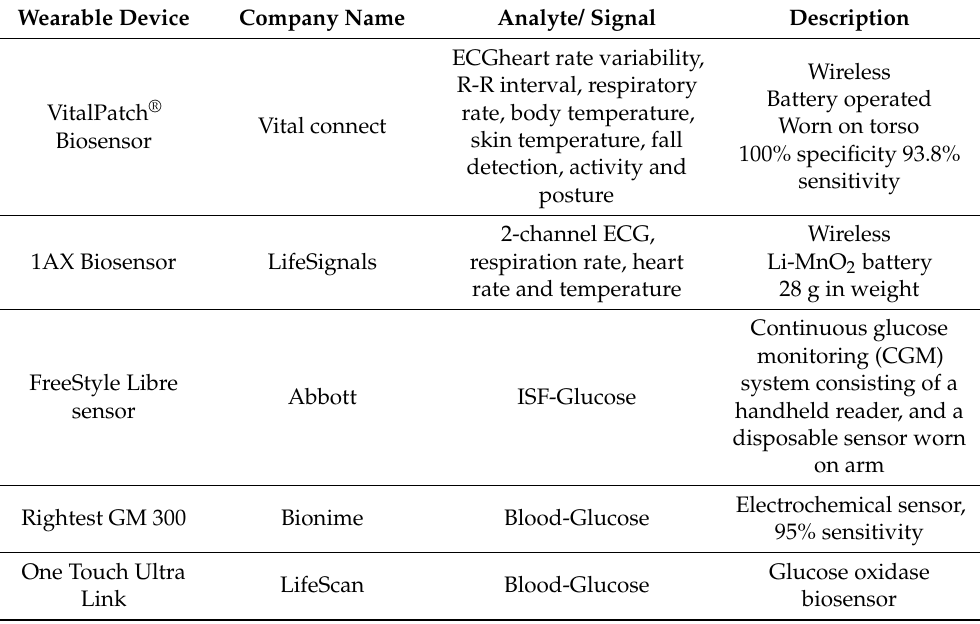
Table 3. List of some of the commercially available wearable